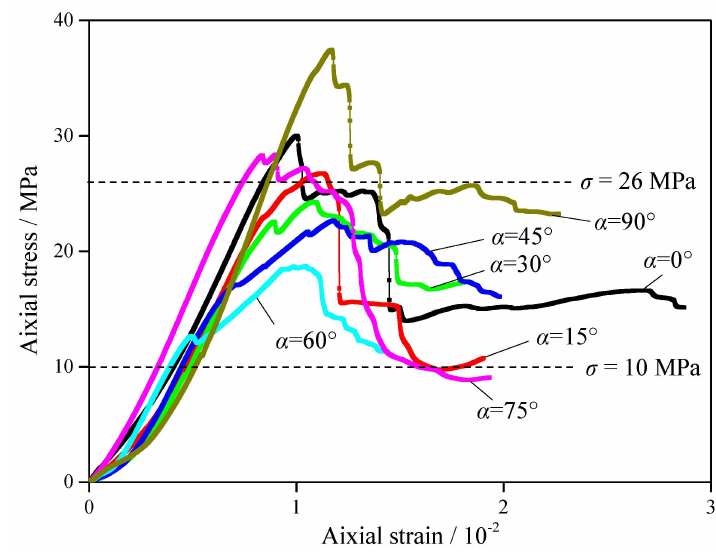
Figure 6. Axial stress–strain curves of specimens with different dip angles under biaxial compression. Table 2. Comparison of mechanical parameters of specimens under uniaxial and biaxial